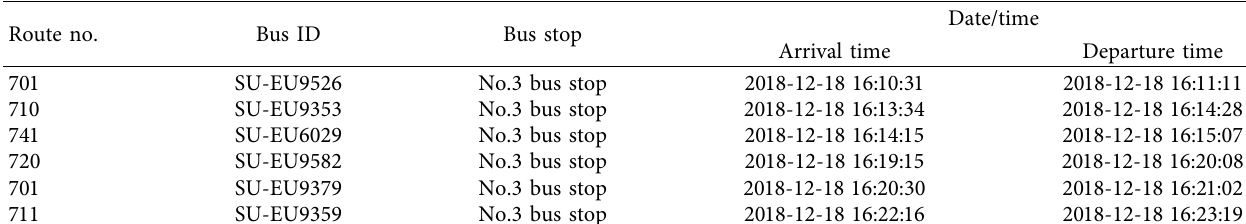
Table 2: Some buses arrival and departure time records extracted from AVL data. Route no.